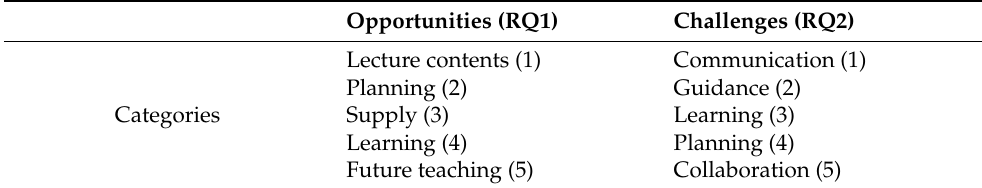
Table 4. A summary of the found opportunities and